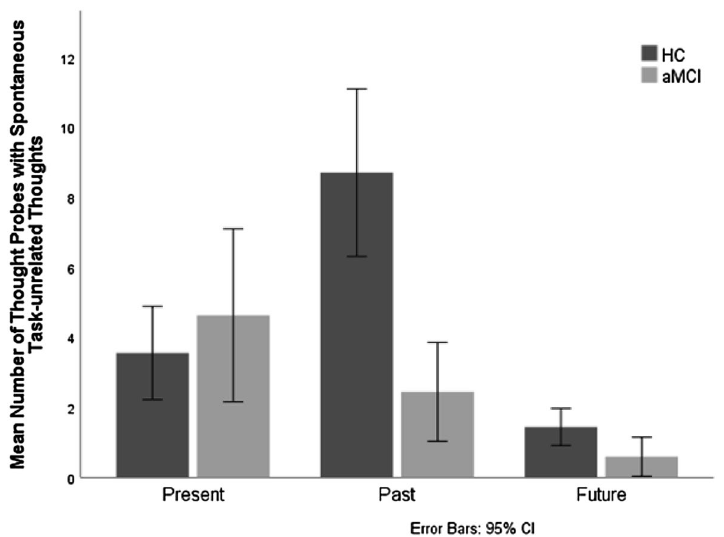
Figure 3. Mean number of thought probes with spontaneous task-unrelated thoughts as a function of temporal orientation (present vs. past vs. future) and group (aMCI participants vs. healthy